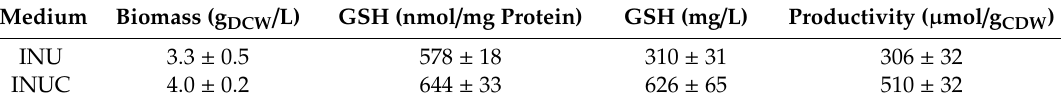
Table 4. Dynamics of GSH and biomass production during the batch cultivation of strain RIY389 (p TEF - ylGSH1-ylGSH2-INU1 ) in INU and INUC. Biomass was given after 24 h; GSH and productivity were determined after 48 h of culture. Data are the mean and standard deviation of two experiments.